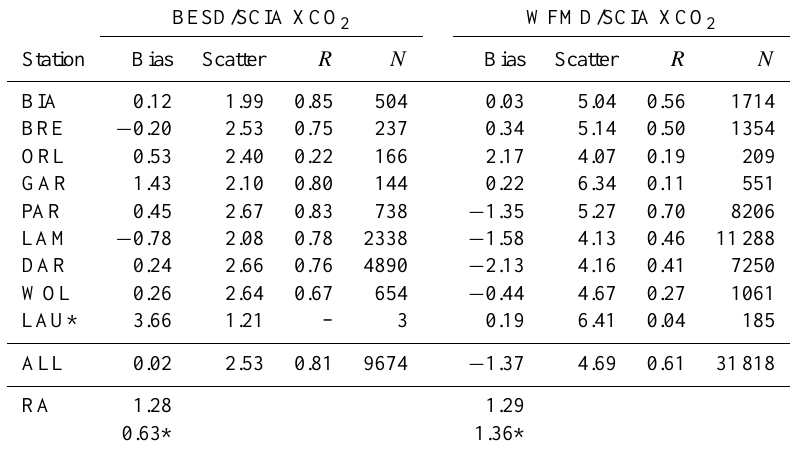
Table 3. BESD and WFMD XCO 2 validation results for all individual stations and using all data combined (ALL). All results apart from R and N are in ppm units. The station flagged by * has been excluded from the relative accuracy calculation.